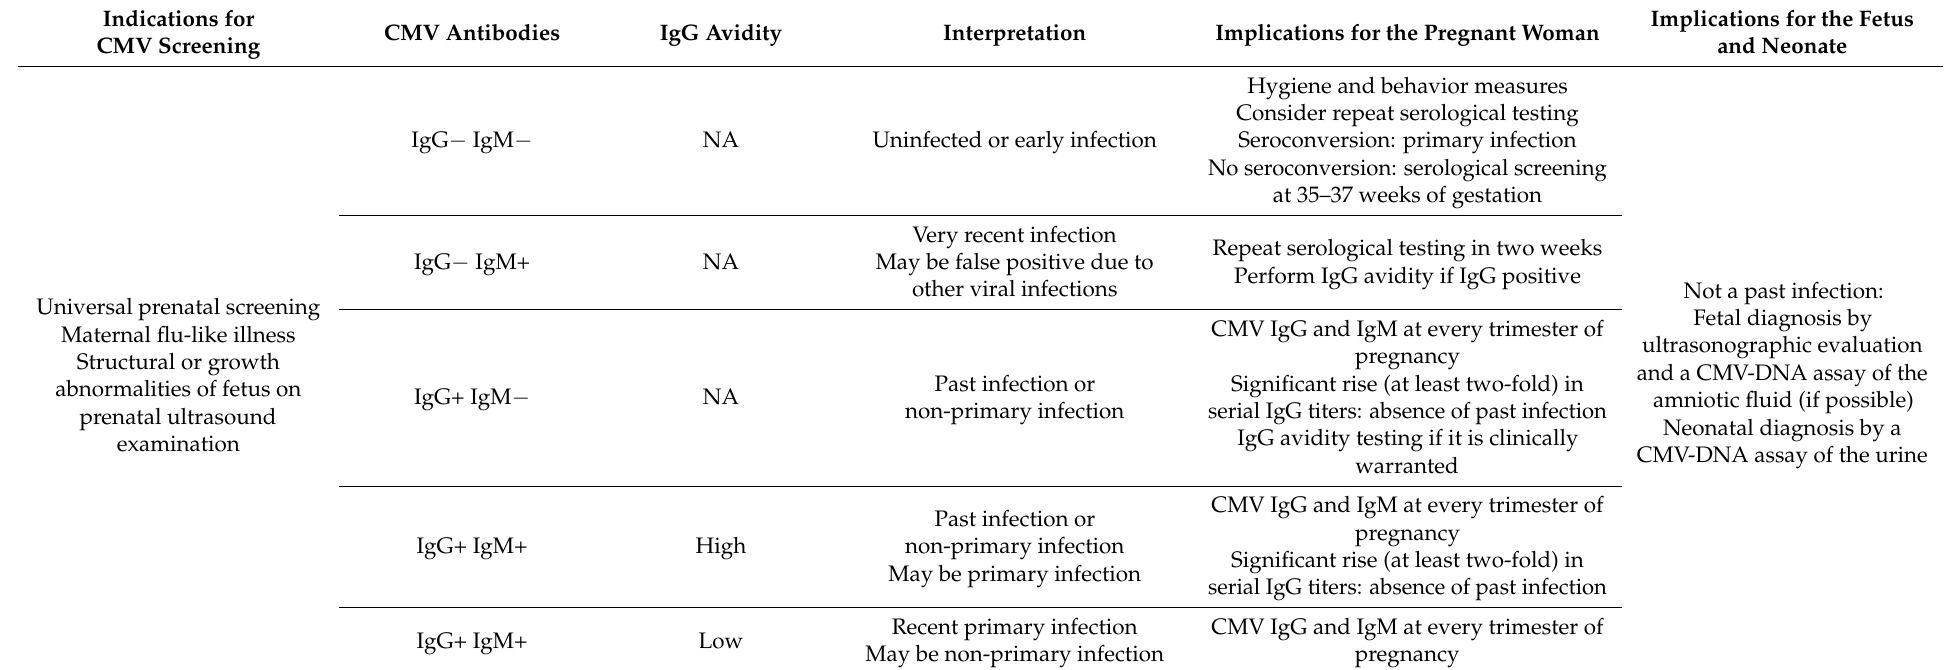
Table 3. Interpretation of cytomegalovirus (CMV) serology in